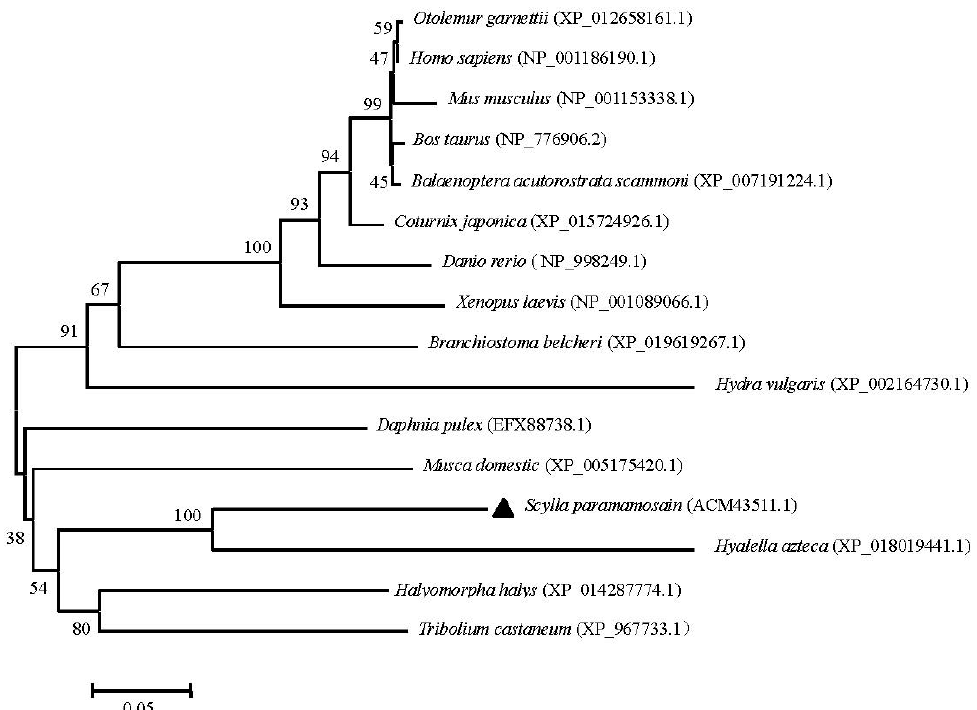
Figure 6. Phylogenetic tree of the UCHL5 amino acid sequences between S. paramamosain and other species. The GenBank codes of species are described in brackets. The Sp- UCHL3 is marked by black triangle. The numbers near the node mean bootstrap values of 1000 replicates.